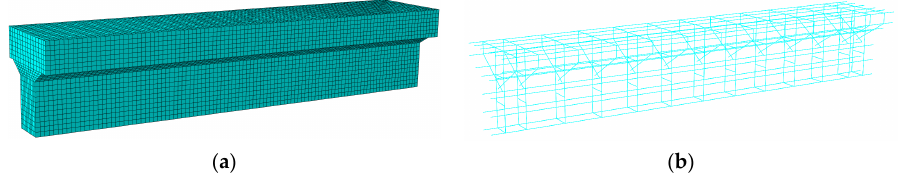
Figure 13. Finite element model of pre-cracked T-beam. ( a ) Concrete T-beam network division; ( b ) Steel cage.